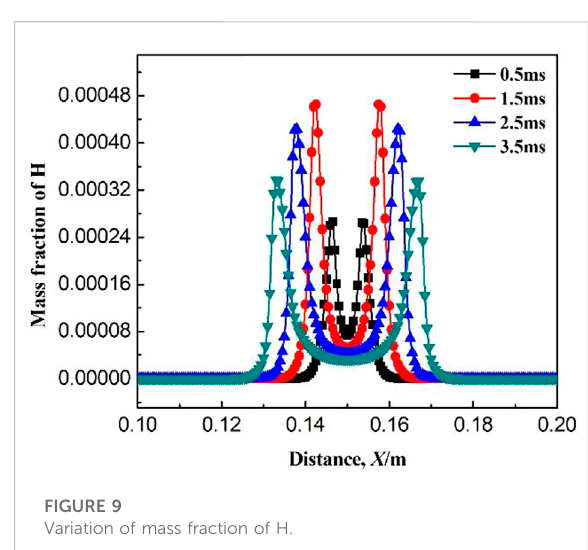
FIGURE 9 Variation of mass fraction of